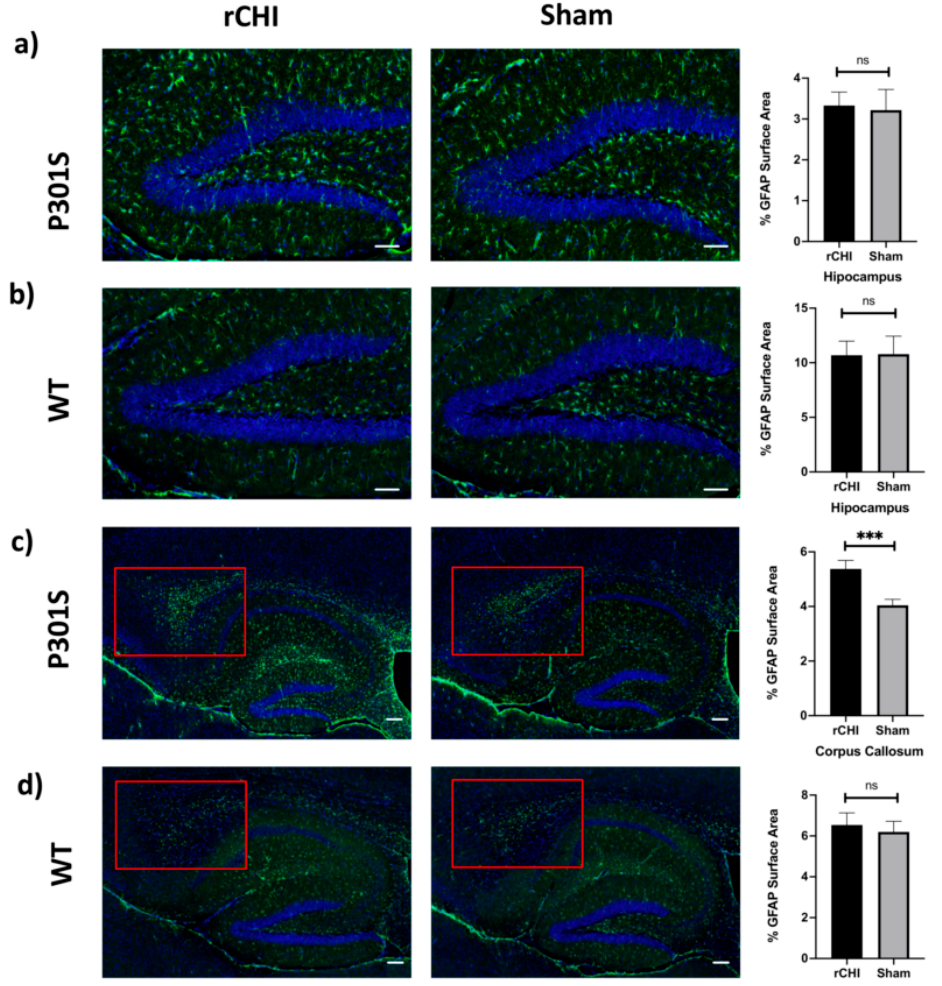
Figure 3. Repetitive closed-head injury (rCHI) increased astrocytosis in adolescent P301S but not in WT mice at 40 days post-injury. ( a , b ) Representative IHC of GFAP staining in the hippocampus of rCHI and sham P301S ( a ) and WT mice ( b ) at 40 days post-injury. Percent area of GFAP staining was not significantly different in the hippocampus of rCHI compared to sham in both P301S and WT mice ( n = 4/group, p = 0.85, p = 0.96, respectively). ( c , d ) Representative IHC of GFAP in the corpus callosum of rCHI and sham P301S ( c ) and WT ( d ) mice at 40 days post-injury. Percent area of GFAP staining was significantly increased in the corpus callosum of rCHI vs. sham P301S mice ( c ), but was not significantly different in in the corpus callosum of rCHI vs. sham WT mice at 40 days post-injury ( d ) ( n = 4/group, p = 0.0009, p = 0.67 respectively). Red box illustrates the increased astrocytosis in the corpus callosum of rCHI compared to sham in P301S, but not in WT, mice groups. Statistical significance is denoted as follows: ns (non-significant) p > 0.05, *** p ≤ 0.001. Scale bars are 50 µ m, and 20 µ m for photomicrographs on increasing